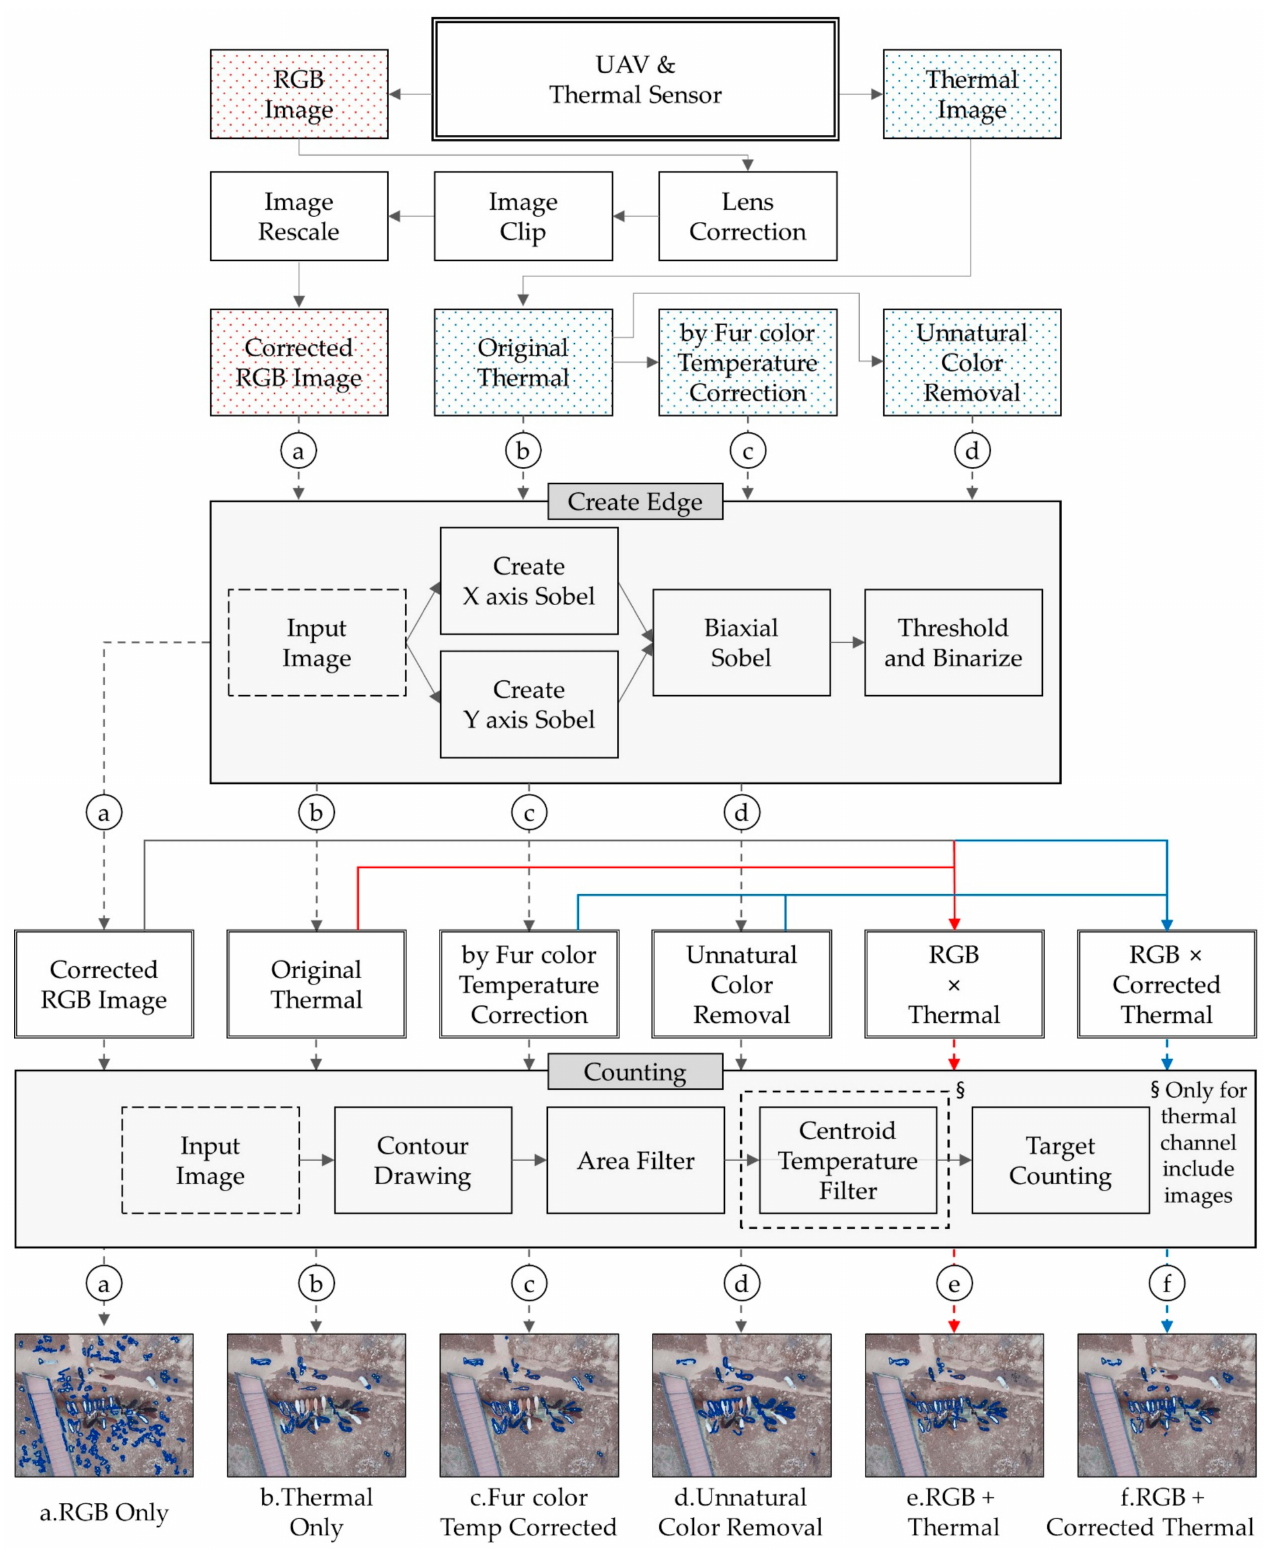
Figure 9. Flowchart of the detection method for all image